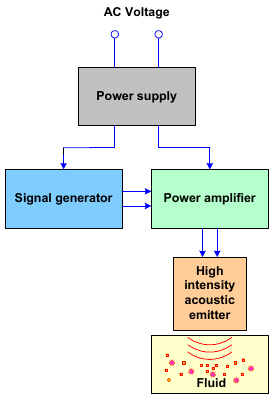
Figure 6. Stages to generate a High-Intensity